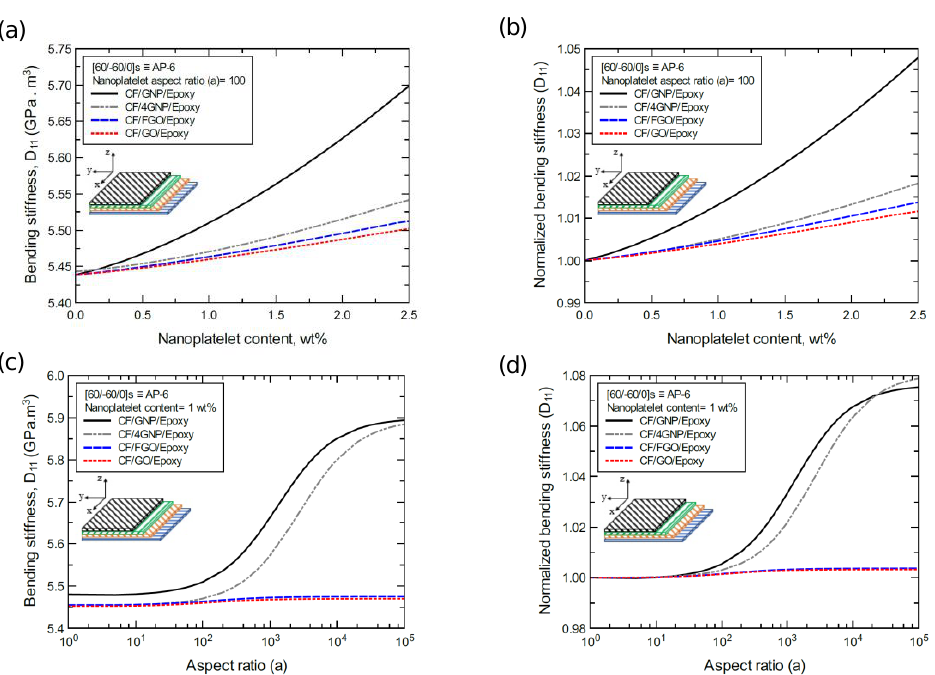
Figure 17. Comparison of the predicted bending stiffness (D 11 ) for a [60/-60/0]s (AP-6)-laminated composite plate based on the nanoplatelet type, content, and aspect ratio; ( a ) predicted D 11 for various nanoplatelet contents at 100 aspect ratio, and the normalized response is shown in ( b ); ( c ) predicted D 11 for various aspect ratio values at 1.0 wt% nanoplatelet content, and the normalized response is shown in ( d ). The volume fraction of CF is 56%.